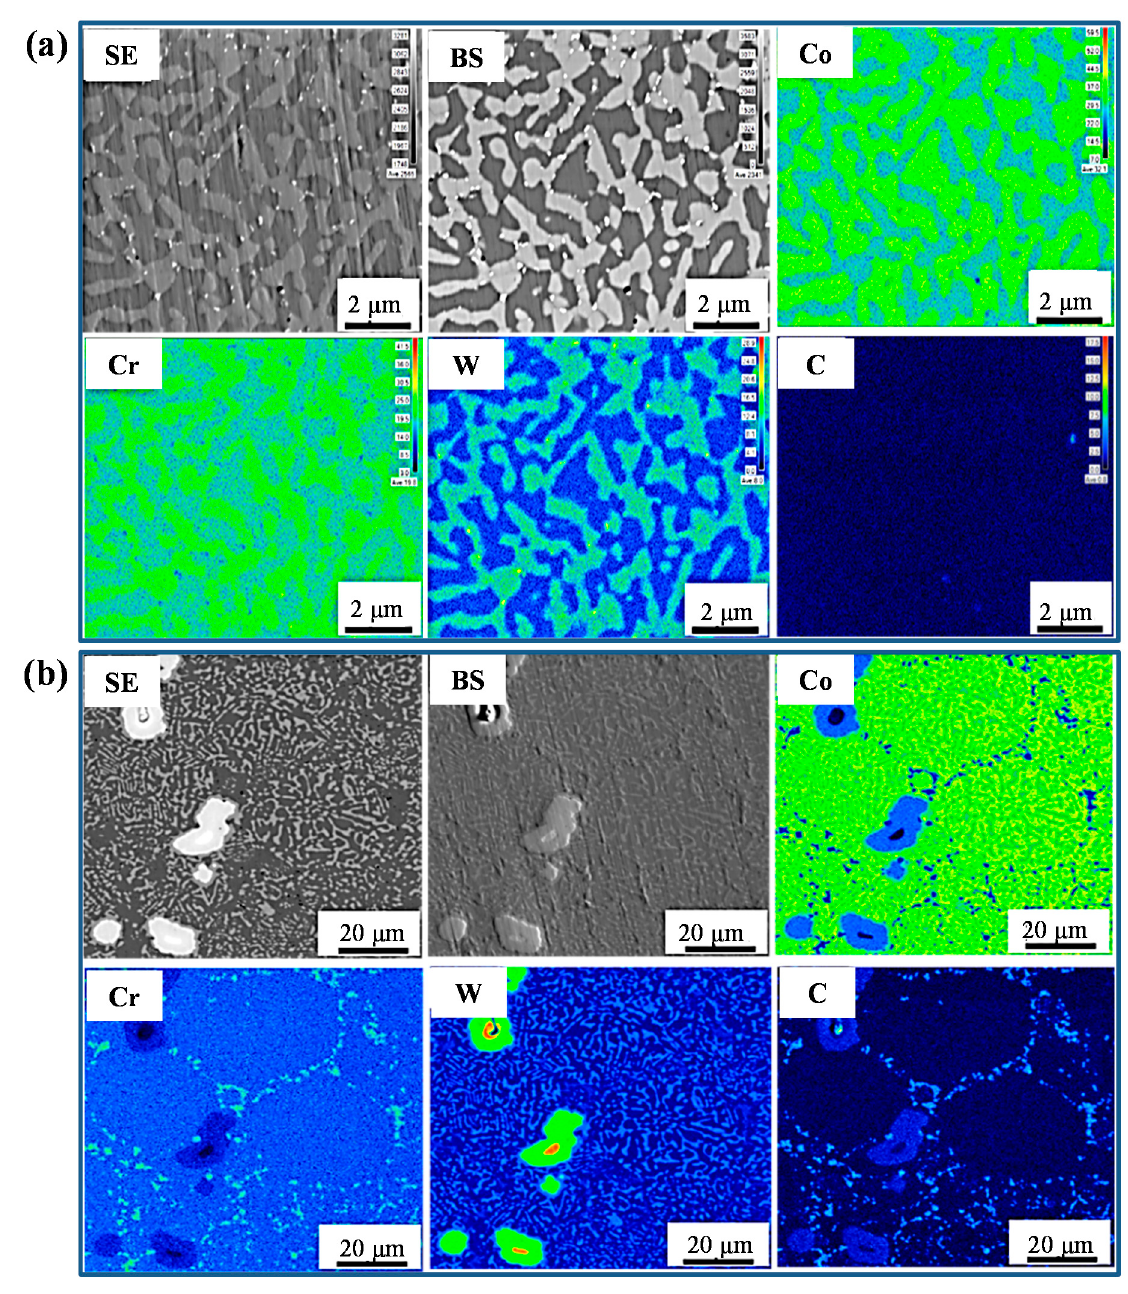
Figure 5. The element distribution maps of a micro-area of the Co–Cr–W alloy and the Co–Cr–W matrix composites. ( a ) Co–Cr–W alloy; ( b ) Co–Cr–W matrix composites.